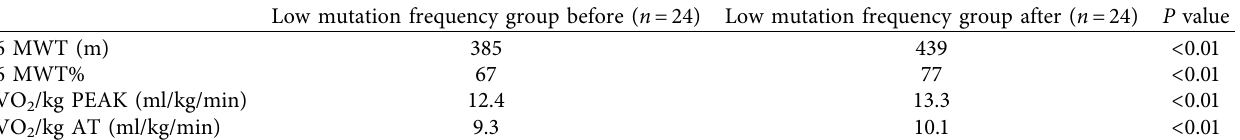
Table 5: Comparison of indices in the low mutation frequency group before and after the 8-week exercise intervention.